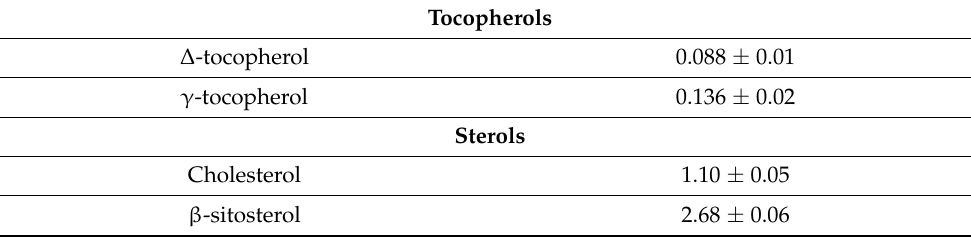
Table 2. Phytochemicalprofileofpomegranateoil. Allvaluesexpressedinmg/mL(mean ±